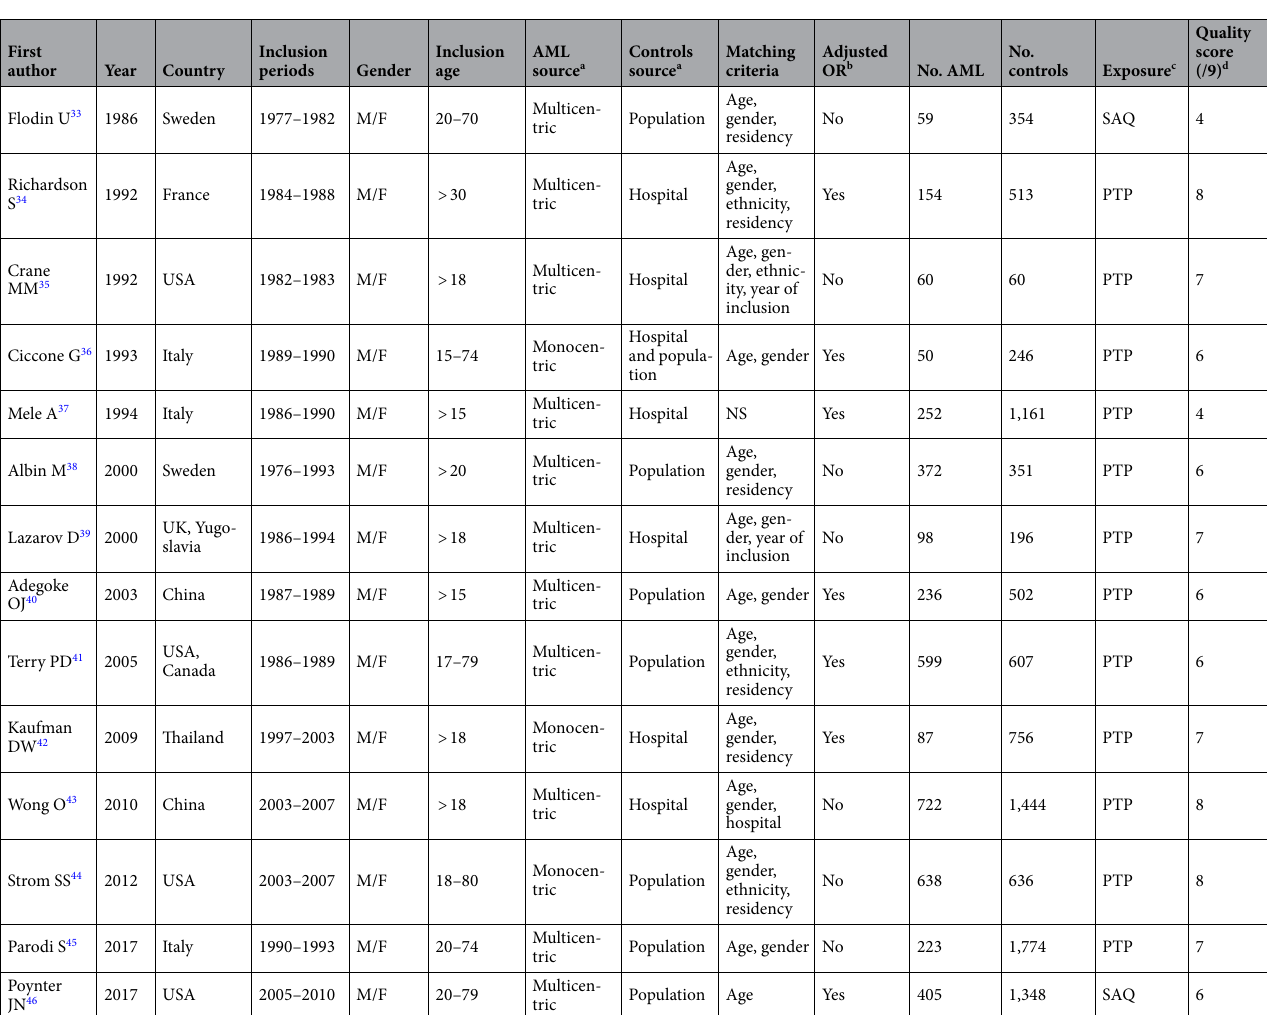
Table 1. Main characteristics of case–control studies included in the meta-analysis evaluating the association of AML and pesticide exposure. a Acute myeloid leukemia (AML) patients and controls source are described in Table S3; b Adjustment variables are fully described in Table S6; c Pesticide exposure methods are fully described in Table S2; d Quality score was evaluated with the Newcastle–Ottawa scale for case–control studies (Table